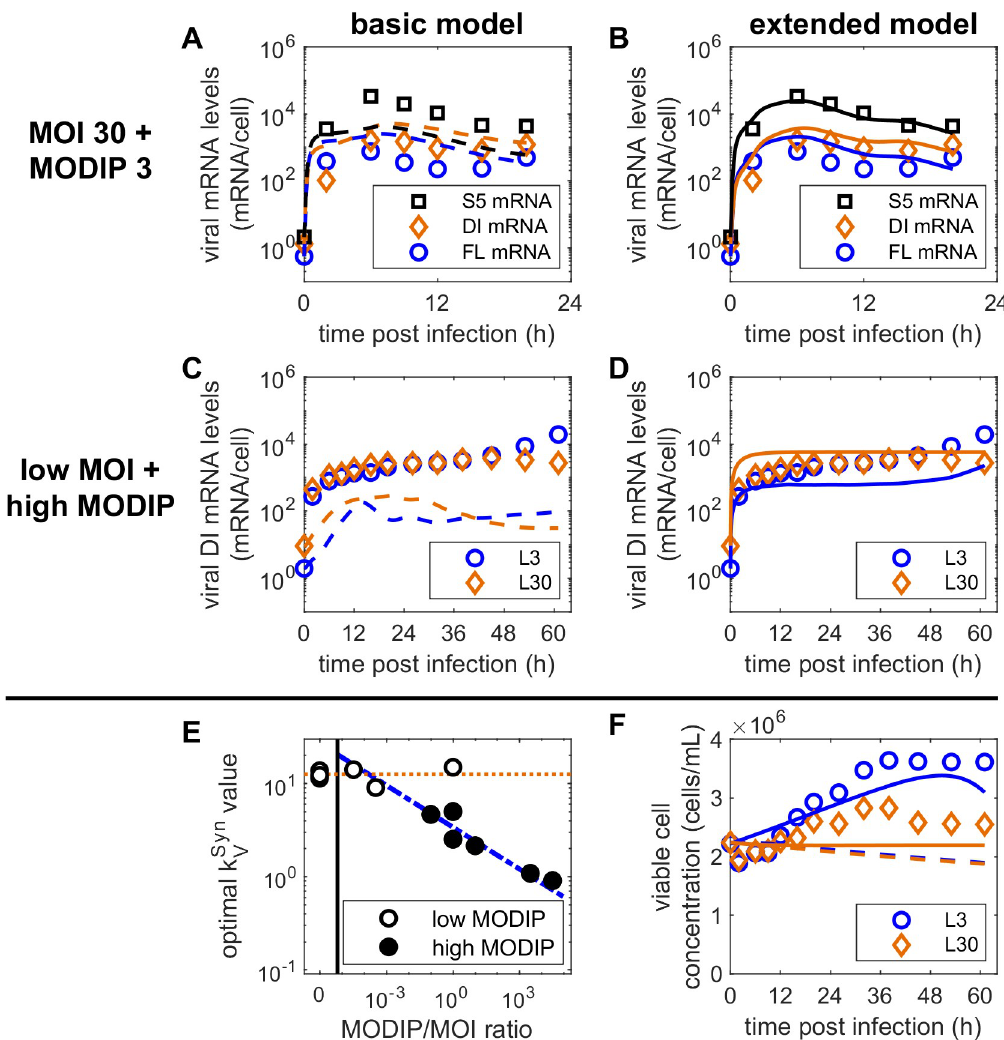
Fig 4. Adaptations of viral RNA synthesis and cell growth mechanisms of the basic model improve the description of observed infection dynamics. (A+C+F) Dashed lines show model simulations of the basic model fitted to experimental data, (B+D+F) solid lines depict simulations of the extended model calibrated to the same measurements. (A+B) Dynamics of viral mRNA for segment 5, full-length segment 1 and defective interfering segment 1 using MOI 30 and MODIP 3. (C+D) Accumulation of viral DI mRNA for conditions L3 (MOI 10 − 3 and MODIP 3) and L30 (MOI 10 − 3 and MODIP 30). (E) Estimated values for the parameter k Syn describing vRNA synthesis for different infection scenarios based on the applied V MODIP-to-MOI ratio. The orange dotted line depicts the average k Syn value for low MODIP infections (empty circles) and the V blue dash-dotted line represents the dependency of k Syn on the MODIP-to-MOI ratio for high MODIP conditions (full circles). V The vertical black line separates infections only using STVs from infections with MODIP > 0. (F) Dynamics of the viable cell concentration for low MOI, high MODIP conditions L3 and L30. Experimental data for all other infection conditions are shown in S1 and S3–S10